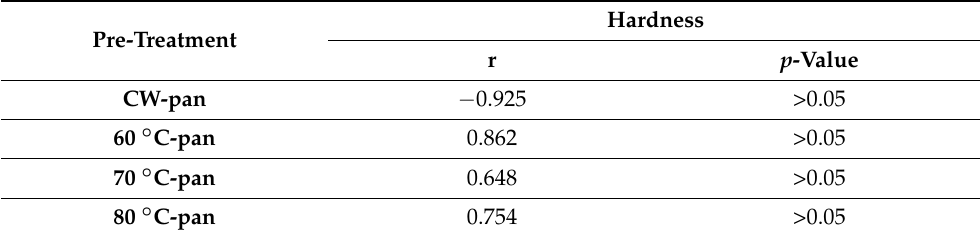
Table 7. Pearson correlation between acrylamide content and hardness of French